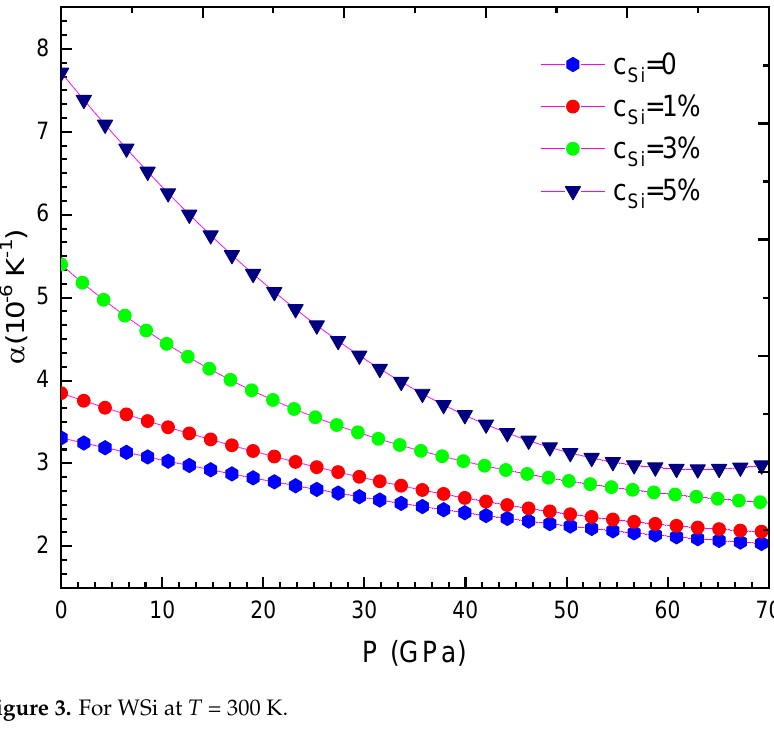
Figure 3. For WSi at T = 300 K.